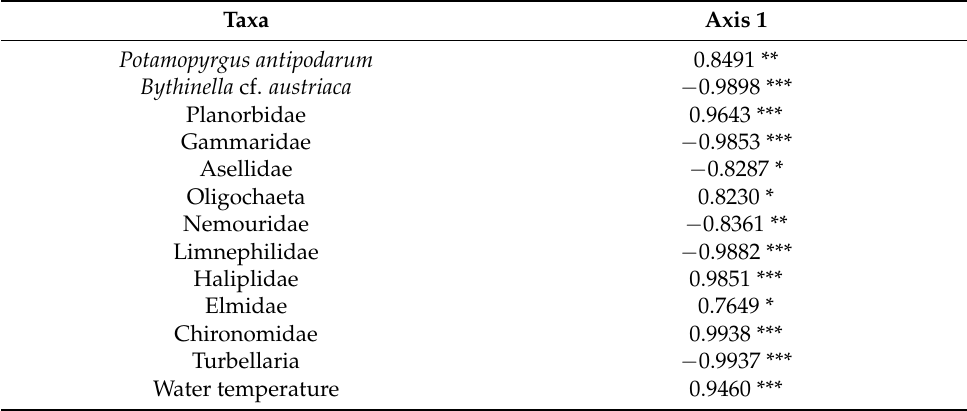
Table 4. Statistically significant correlation coefficients between the macroinvertebrate taxa, environ- mental variable and the NMDS axis 1.